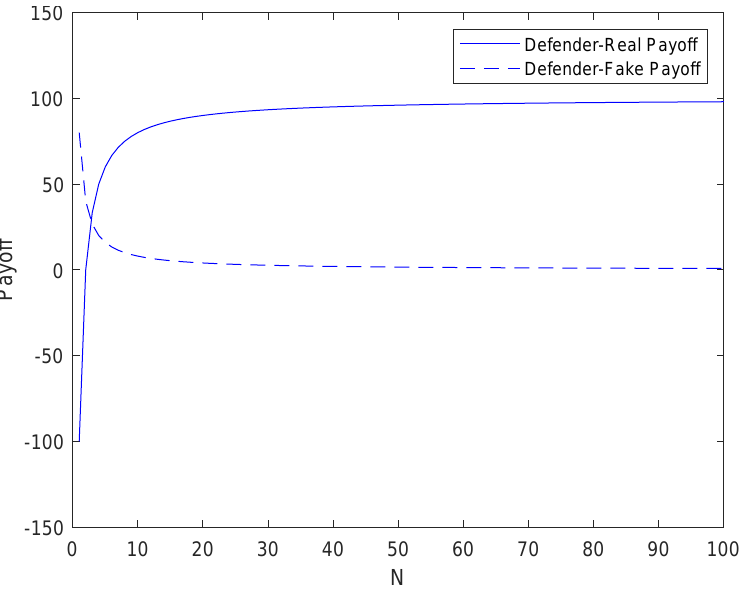
Figure 6. Payoff curves of the